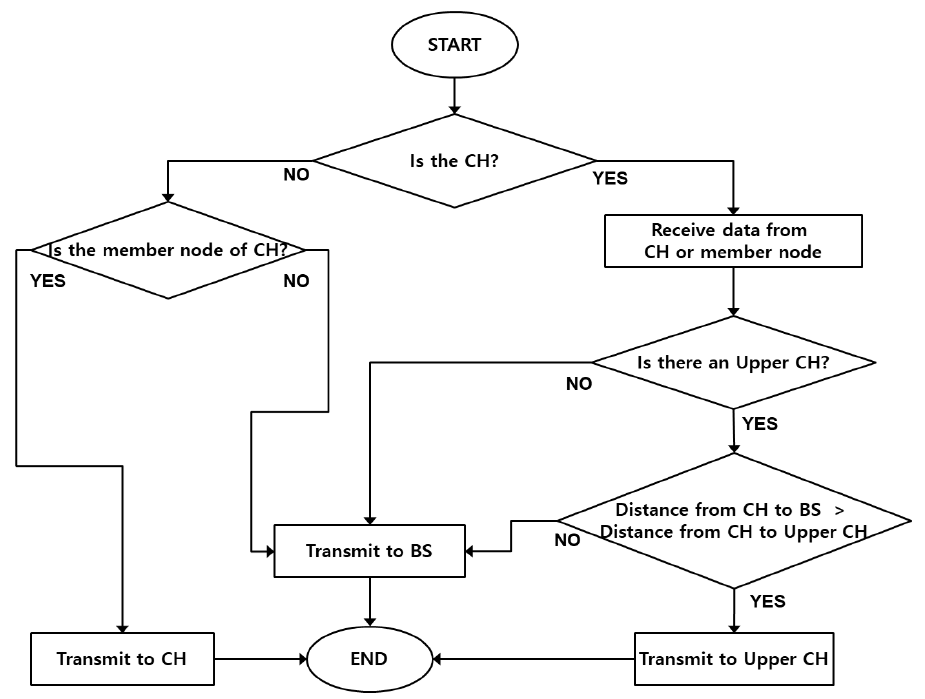
Figure 11. Data transmission process of the sensor